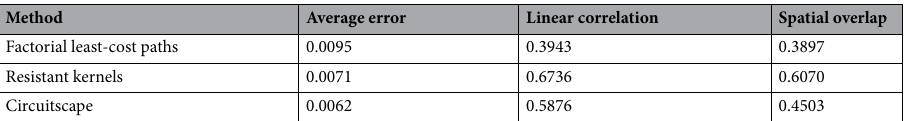
Table 2. Results from the first study, in which we test the accuracy of factorial least-cost paths, resistant kernels and Circuitscape across 1,764 connectivity scenarios without destination bias. This table displays the overall (1) average root-mean-squared error, (2) linear correlation and (3) degree of spatial overlap, between the simulated connectivity surfaces and the predictions given by these three